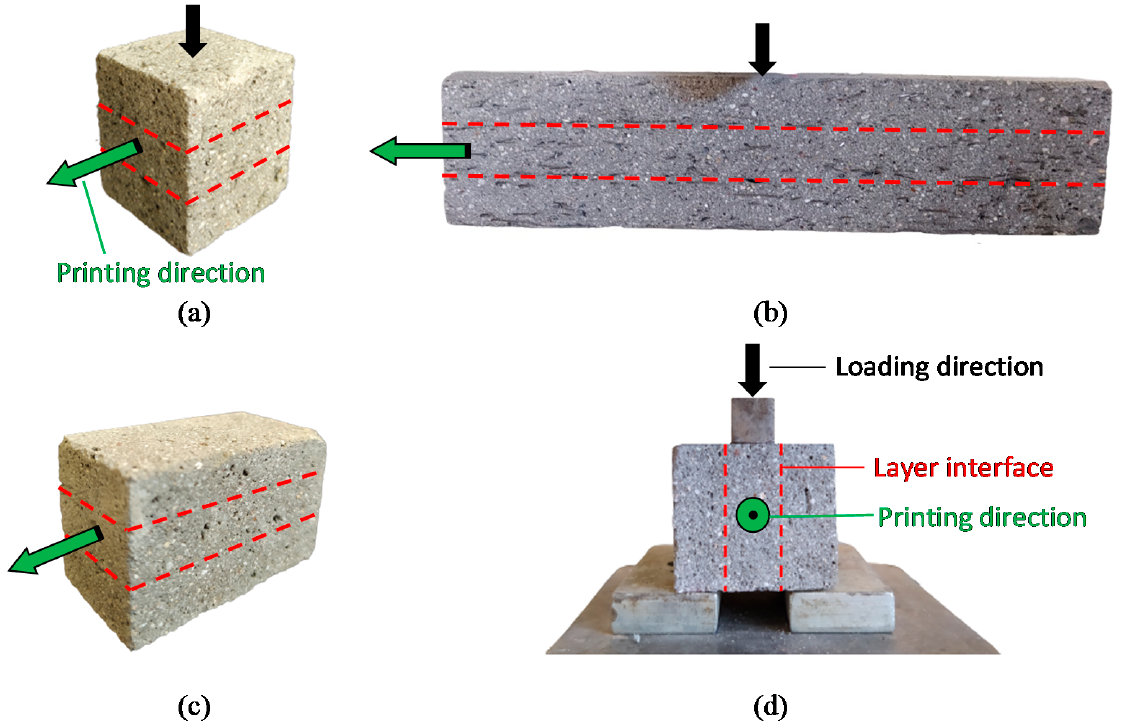
Figure 7. Compressive ( a ), flexural ( b ), shear bond ( c ) strength test specimens, and shear bond testing ( d ).